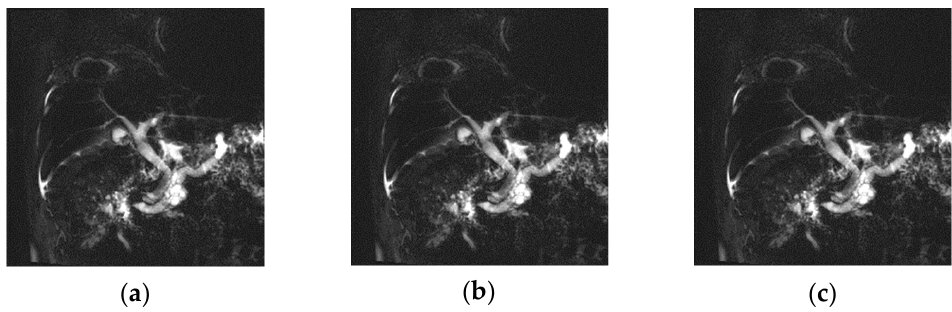
Figure 8. Patient with Intraductal Papillary Mucinous Neoplasm. MRCP MIP images obtained with RT-2D-CS TSE sequence ( a ), RT-2D-SENSE TSE sequence ( b ), and BH-2D-SSh TSE sequence ( c ) images.